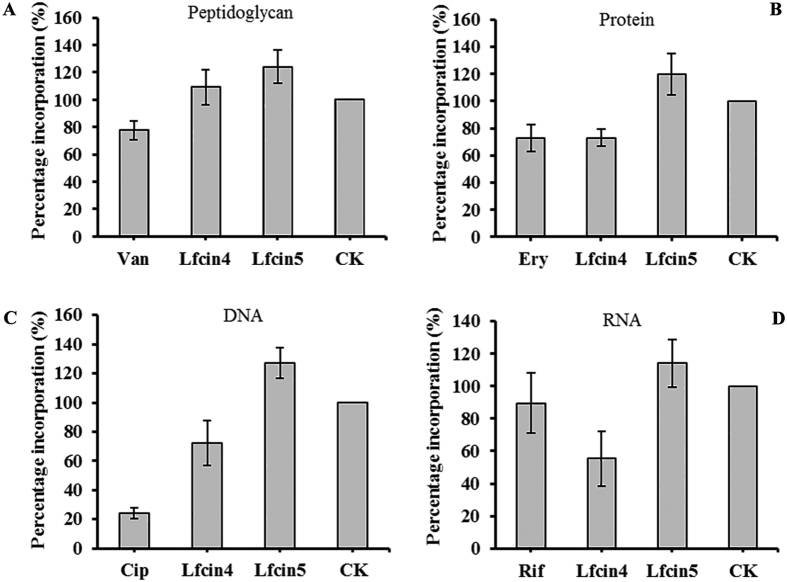
Effects of Lfcin4 and Lfcin5 on macromolecular synthesis in S. aureus ATCC25923.Incorporation of 3H-glucosamine hydrochloride (peptidoglycan) (A), 3H-leucine (protein) (B), 3H-thymidine (DNA) (C), and 3H-uridine (RNA) (D) was determined in cells treated with 1 × MIC Lfcin4 and Lfcin5. Van: vancomycin (2 × MIC); Ery: erythromycin (2 × MIC); Cip: ciprofloxacin (8 × MIC); Rif: rifampicin (4 × MIC). Antibiotics were used as controls. Results are presented as the mean ± SEM (n = 3).